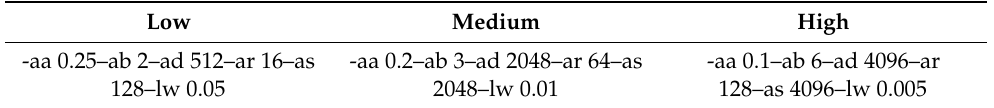
Table 1. Radiance parameter settings.